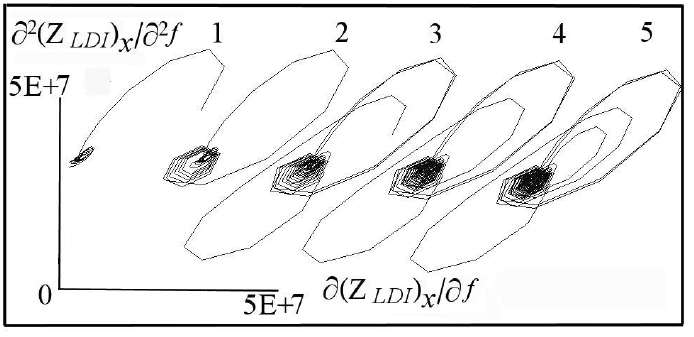
Figure 15. Series of disorderly episodes for convergence and divergence from Figure 14(2). Loops running